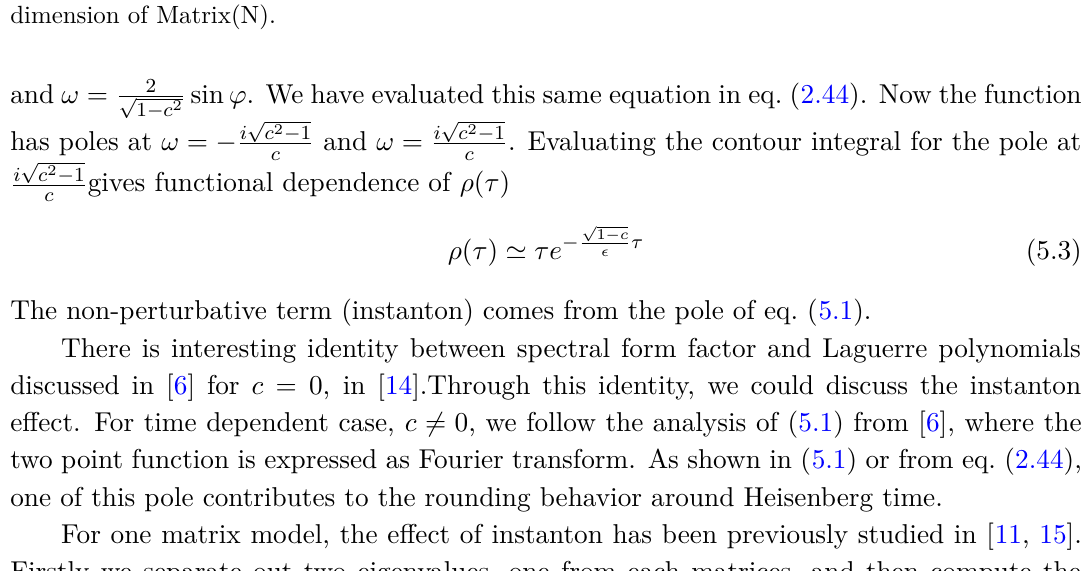
Figure 14 . Spectral Form Factor for same matrix interaction w.r.t. t for different c = e − t and dimension of